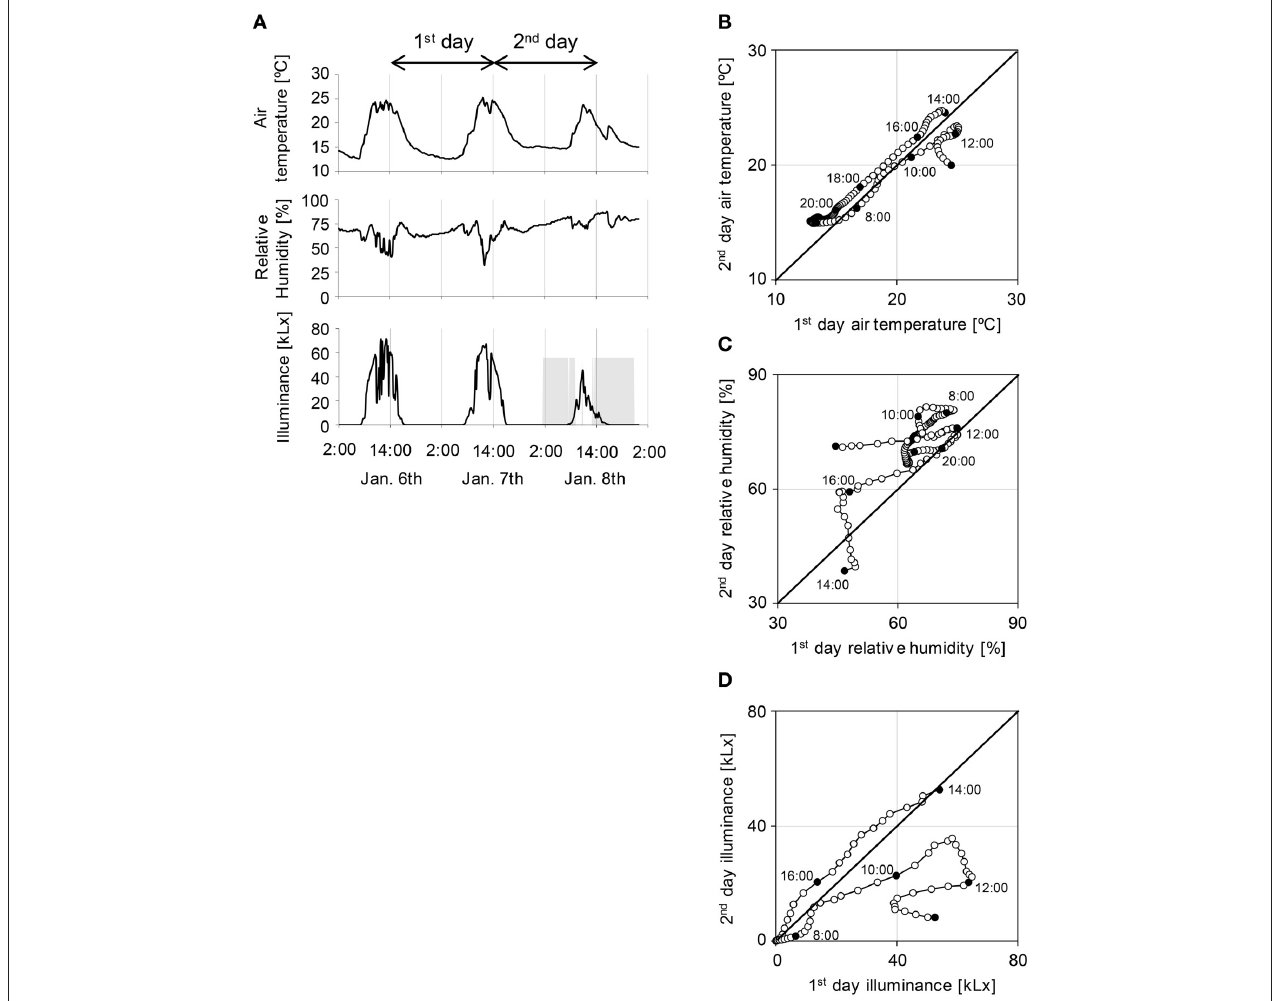
FIGURE 1 | Environmental conditions in a sunlight-type plant factory in Ehime University (A) and comparison of the 1st with the 2nd day for each environmental condition (B–D). (A) Air temperature, relative humidity, and illuminance in a sunlight-type plant factory. Gray area of illuminance indicates precipitation. (B–D) Open circles indicate each values for every 10min and filled circles indicate the sampling point. Sampling started at 14:00.